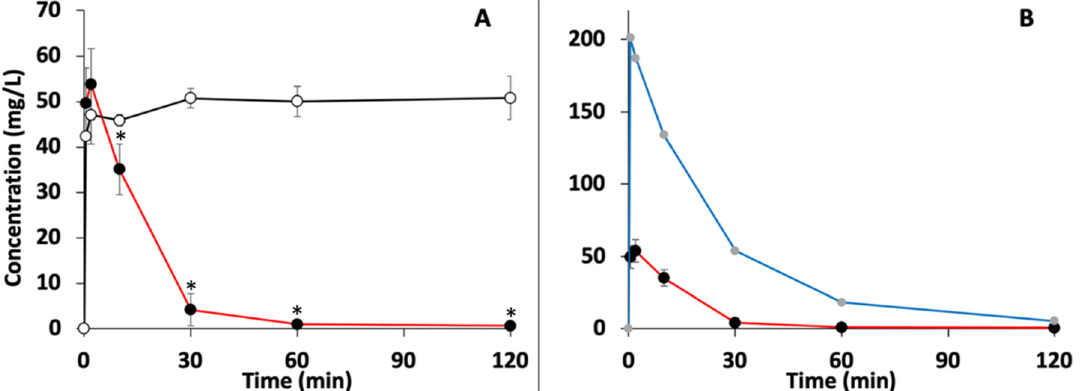
Figure 2. In vitro experiment. ( A ) Amiodarone concentration (mg/L) over time (min) measured in 100 mg amiodarone ECMO group (red line) ( n = 3) and in 100 mg amiodarone control group (black line) ( n = 3). ( B ) Amiodarone concentration (mg/L) over time (min) measured in 100 mg amiodarone ECMO group (red line) ( n = 3) and in 300 mg amiodarone ECMO group (blue line) ( n = 1). Data are presented as mean ± standard deviation. (*) statistically different in comparison to the control group ( p < 0.05). Data are plotted for the first 2 h period. A very slight decrease in amiodarone concentrations was observed between 2 and 24 h (not shown). Table 1. Body weight and hemodynamic parameters during cardiopulmonary resuscitation (CPR). Results are presented as median and interquartile range. No significant difference was observed between control and ECMO groups ( p <